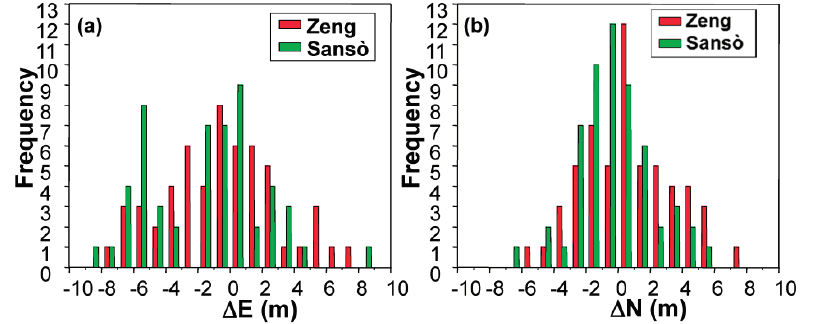
Figure 4. Results from images taken on Mt Etna: residuals between the coordinates of Check Points (CP) and those measured of the orthophotos obtained using the Zeng (red bars) and quaternion (green bars) approaches. ( a ) East coordinates; ( b ) North